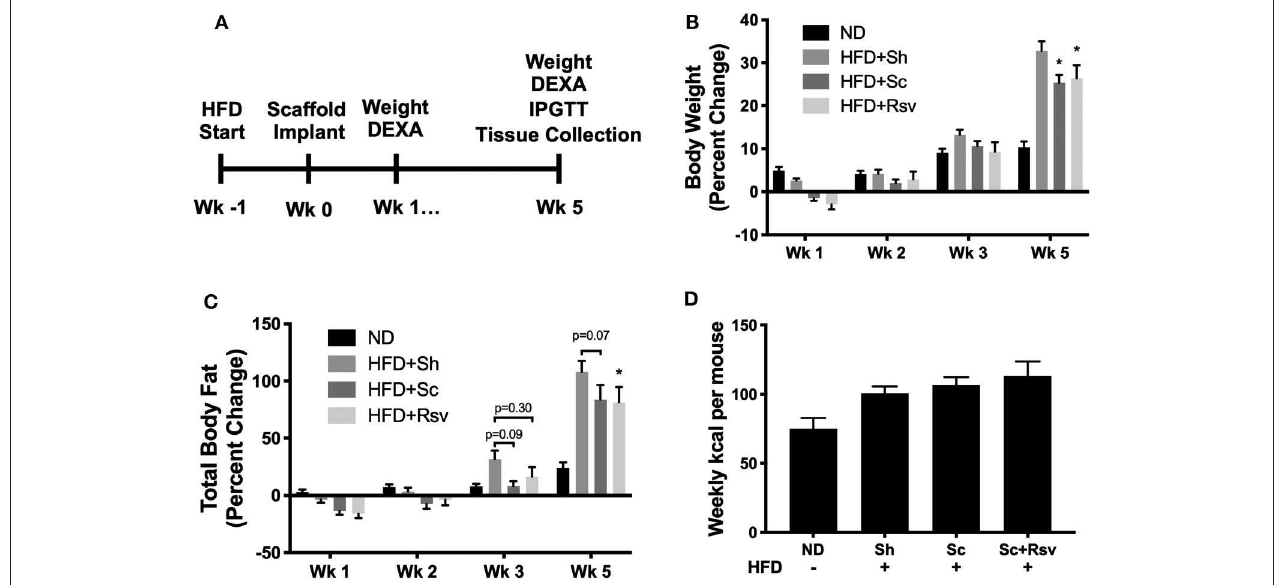
FIGURE 2 | Effect of scaffolds on body composition in high fat diet fed mice. (A) Timeline of the study. (B) Percent change in body weight relative to the day of scaffold implant. Normal diet (ND) mice did not receive the implant procedure and demonstrate growth kinetics of unmanipulated mice on a chow diet. (C) Percent change in fat mass relative to the day of scaffold implant. (D) Weekly kcal intake per mouse over the 5-week experiment. For body weight and composition, statistics were calculated by two-way ANOVA with a Tukey’s multiple comparisons test. For food consumption, statistics were calculated by one-way ANOVA with a Tukey’s multiple comparisons test. * p < 0.05 vs. HFD + Sh. For all conditions and timepoints n = 5 mice. ND, normal diet; HFD, high fat diet; Sh, sham; Sc, blank scaffold; Sc + Rsv, resveratrol